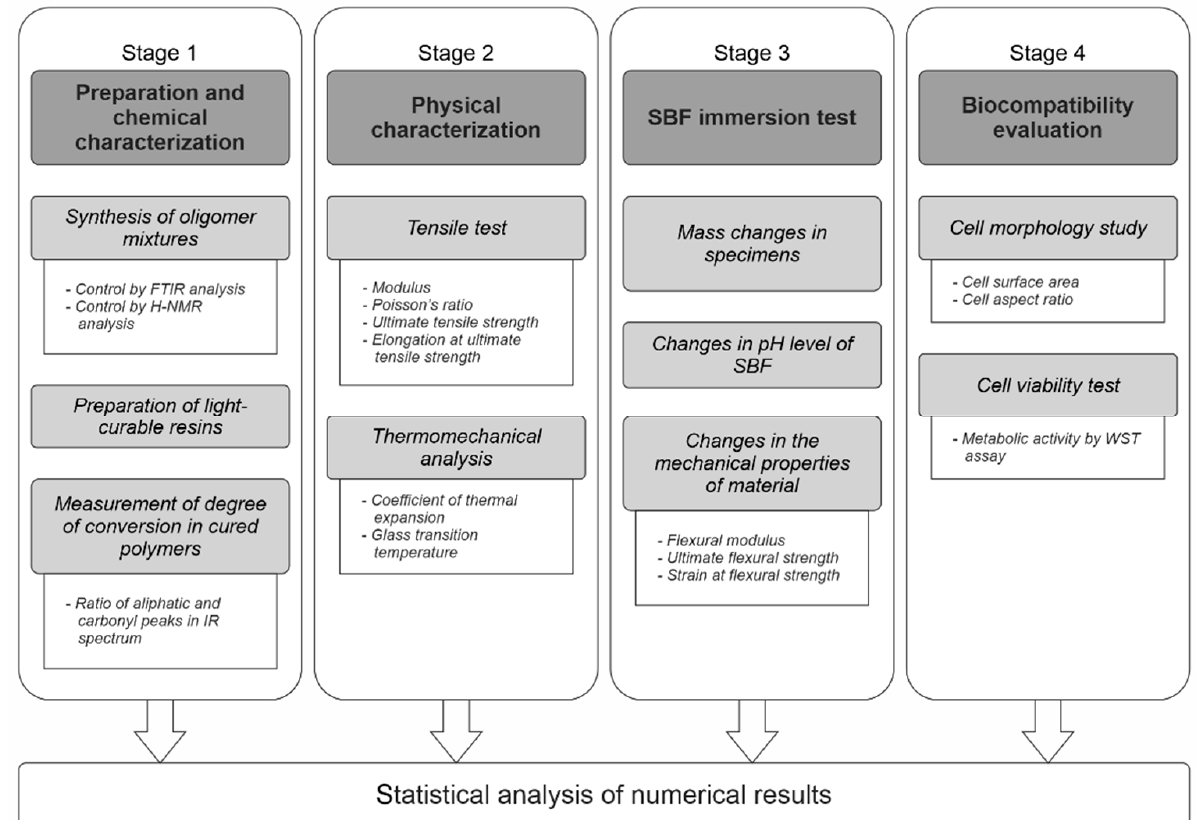
Table 1. Groups of materials used in the study.